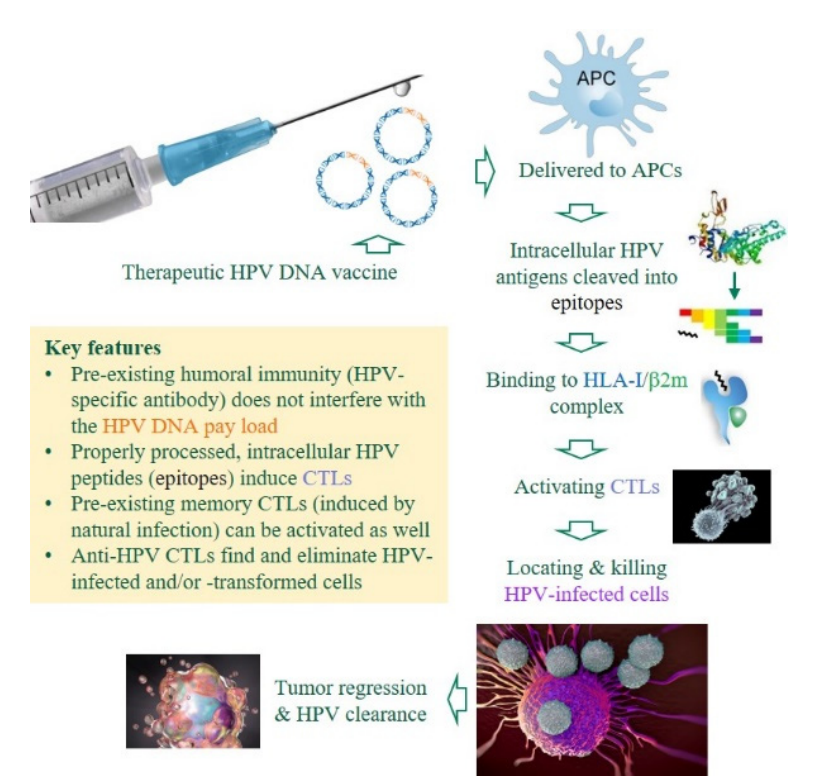
Figure 2. Premises and advantages of DNA-based, therapeutic anti-HPV vaccines. Unlike prophy- lactic HPV vaccines that induce HPV-specific antibodies to neutralize invading viruses, therapeutic DNA vaccines against HPV-induced malignancies must induce cytotoxic T-lymphocytes (CTLs) to eliminate HPV-infected or -transformed cells in patients with chronic/persistent infections [23,24]. Several critical components are color-coded. APCs, antigen-presenting cells; HLA-I, human leukocyte antigen class I (class I heavy chain); β 2m, β 2 microglobulin (class I light chain).